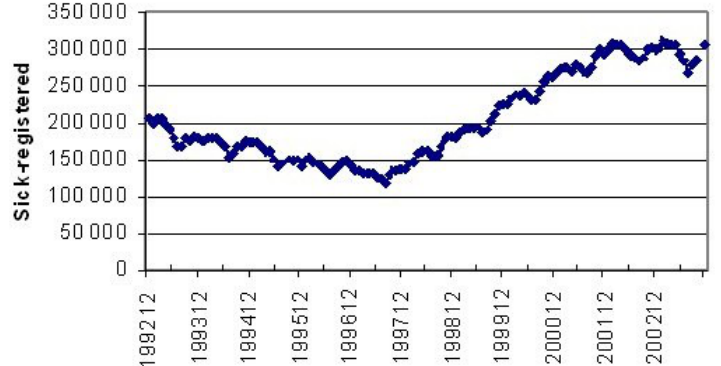
Figure 23. Every summer the number of sick registered in Sweden drops. In 1997 the general trend got